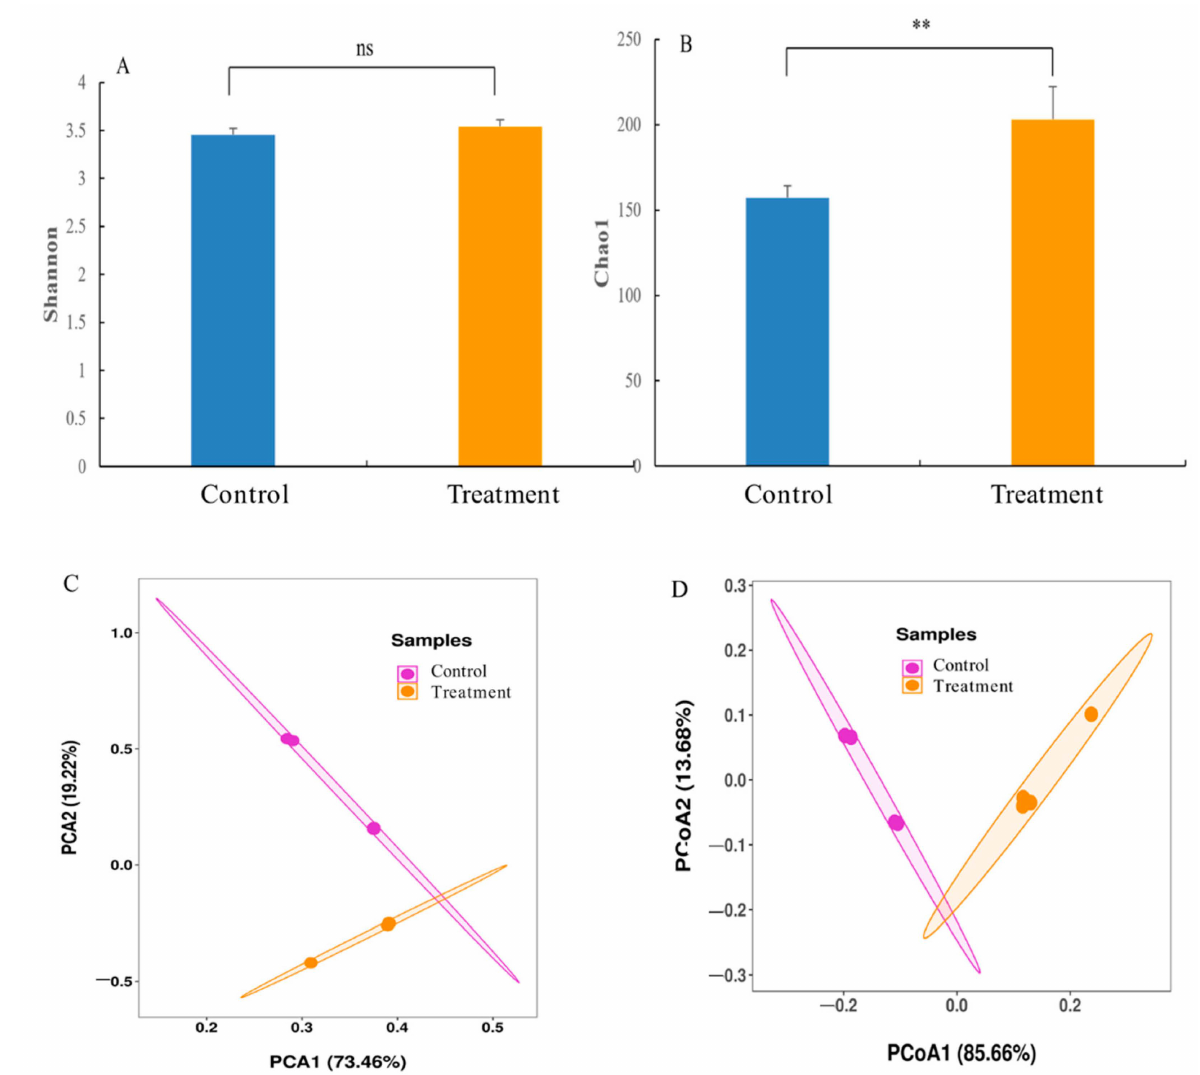
Figure 4. The gut microbial diversity in the H. cunea larvae at the 6th instar after rearing on untreated or tannic acid-treated diets ( n = 4). ( A ) Chao1 index. ( B ) Shannon index. ( C ) Principal components analysis (PCA). ( D ) PCoA plot of the gut microbiota structures based on the unweighted UniFrac analysis. Asterisk indicates significant differences between control/treatment groups (independent samples t -test; **, p <